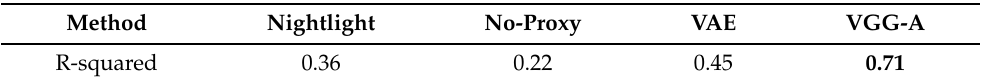
Table 2. Results of different methods. The county-level GDP for training and testing is logarithmically transformed since they are approximately log-normal.